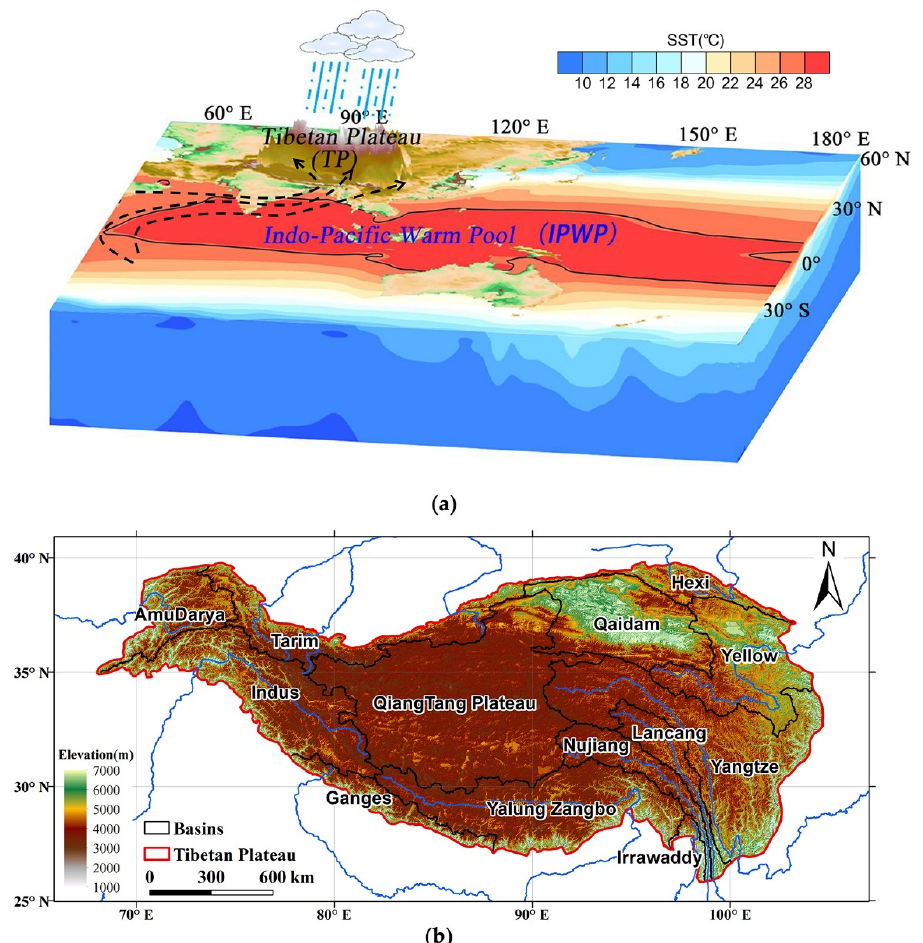
Figure 1. ( a ) Schematic diagram of the water vapor transport process from the Indo-Pacific Warm Pool (IPWP) to the Tibetan Plateau (TP) during boreal summer (June–July–August, JJA), where the black solid line denotes the boundary of IPWP, and the black dotted lines denote the water vapor transport channels and sub-channels. ( b ) The TP and its 13 internal basins.